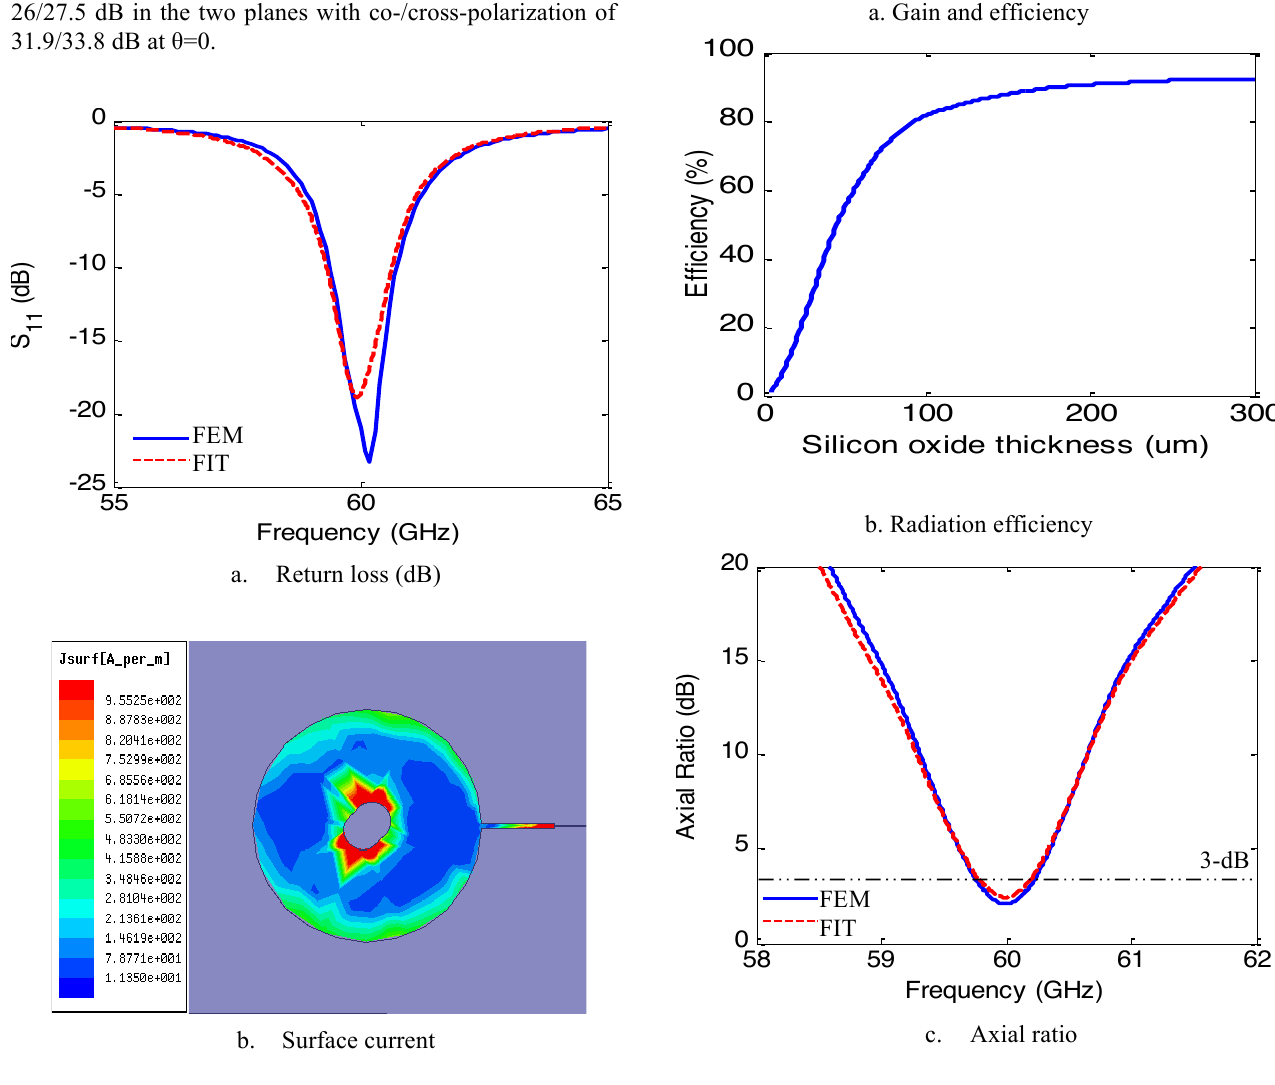
Fig. 2 a. The variation of return loss versus frequency of CP microstrip patch on-chip antenna. b. The surface current distribution on the CP microstrip patch on-chip antenna at 60 GHz.